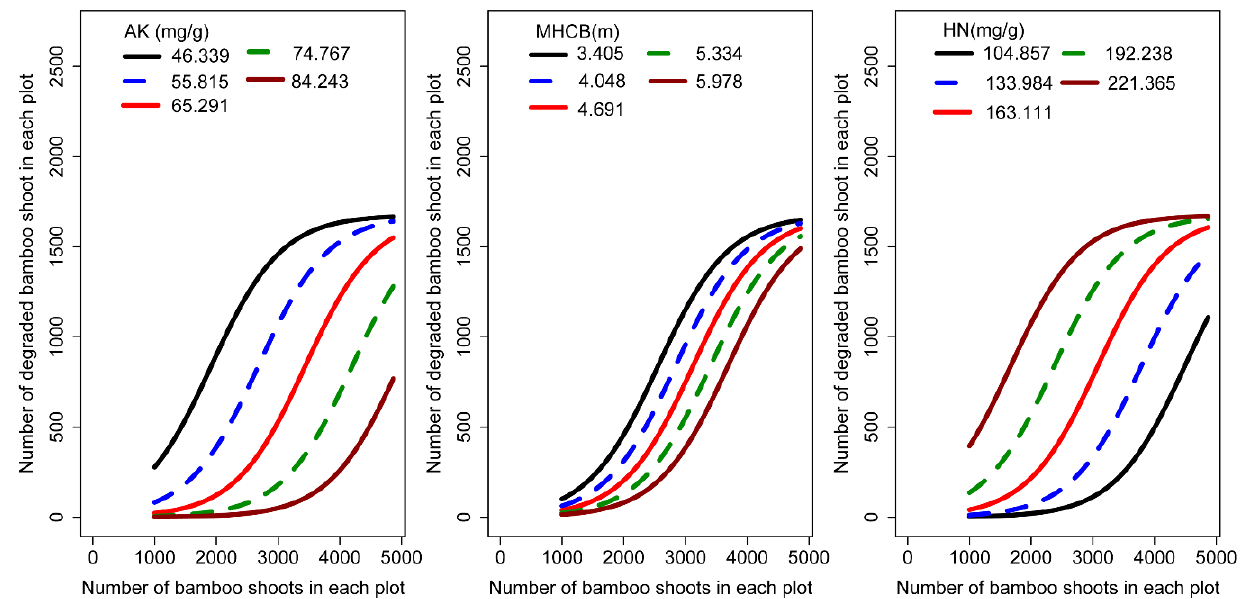
Figure 5. Effects of MHCB, AK, and HN on the DBS. The curves were produced using parameter estimates in Table 3 (logistic model). Table 5. Parameter estimates and fit statistics of the one-level nonlinear mixed-effects DBS models (Equations (1)–(3), (5), and